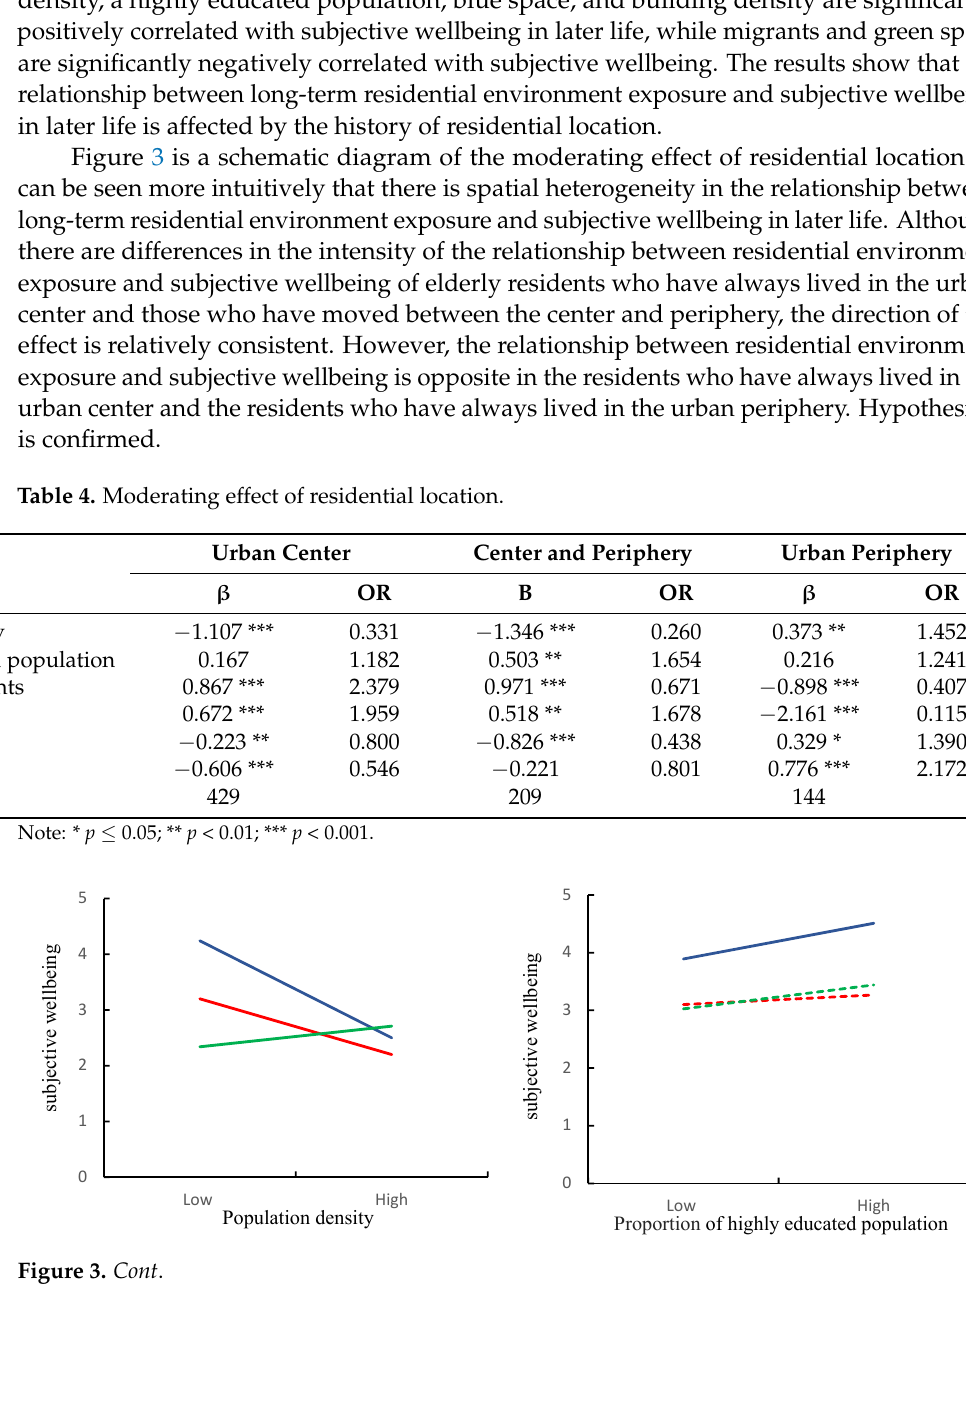
Figure 3. Moderating effect of residential location. Note: Solid lines represent statistical significance at the 90% confidence interval, while dashed lines do not. 4.3. Robustness Check In China’s market economy transformation and housing reform, institutional and market factors play an important role in housing choice and quality of life [63]. Based on this, the study adds relevant institutional factors and market factors as control variables to test the robustness of the conclusions. We selected the type of hukou and the nature of work unit before retirement as institutional factors because they are the product of China’s institutional system. Whether residents have local hukou and the associated entitlements and whether they work in a state ‐ owned enterprise or public institution directly affect the quality of residents’ access to public services such as medical care and education. In addi ‐ tion, personal monthly income and full ‐ time or part ‐ time employment before retirement are selected as market factors because they are closely related to the market economy.